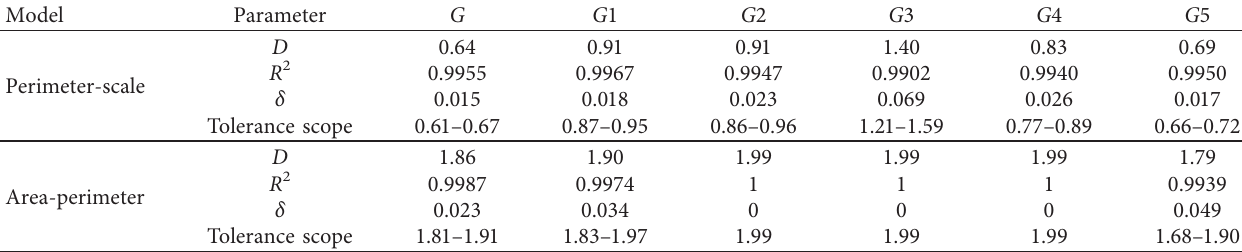
Table 3: Fractal dimension results and confidence statements of various types of green spaces calculated by using the boundary dimension.